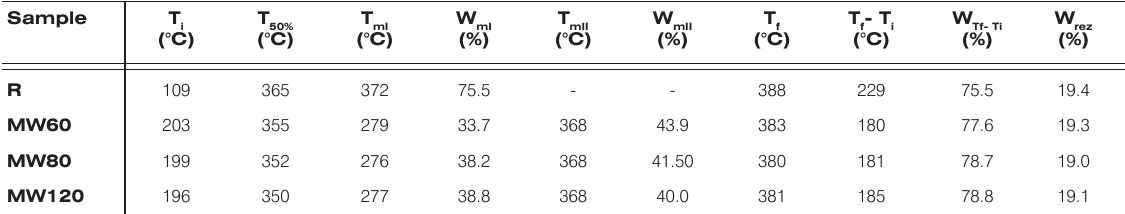
Table 6. Some data evaluated from TG and DTG curves.